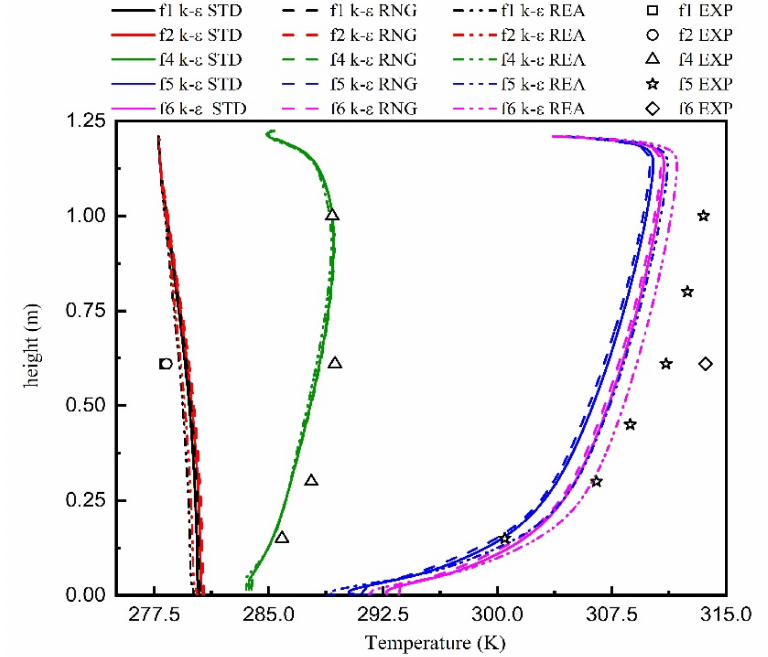
Figure 9. Experimental and numerical temperatures for the three glazings, according to k- ε models with a standard wall